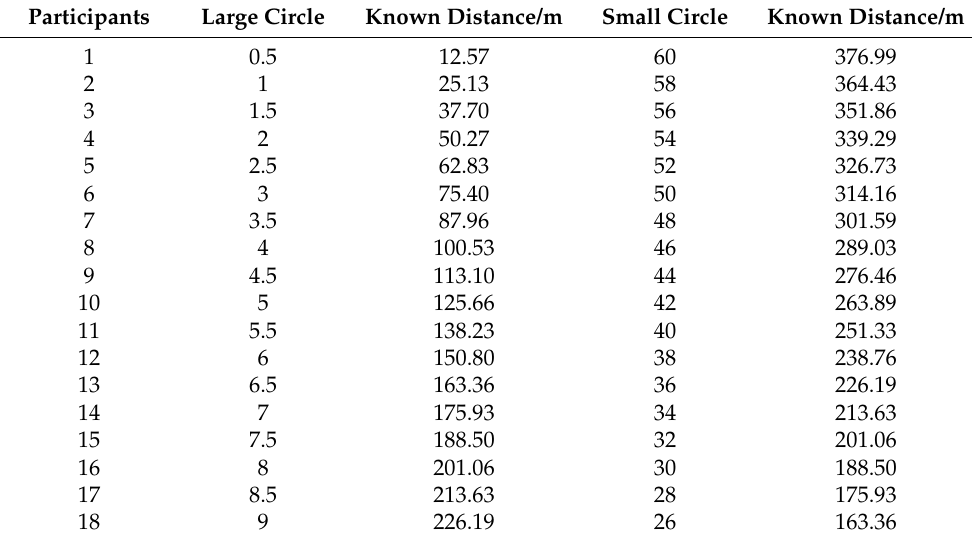
Table 2. Number of laps and distance traveled around the small and large circles.